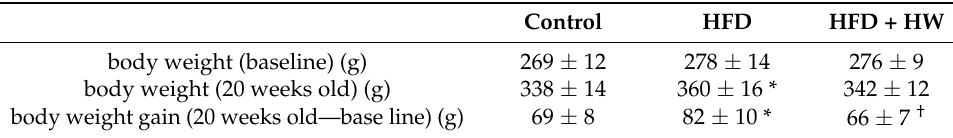
Table 1. Changes in body weight during the experimental period.